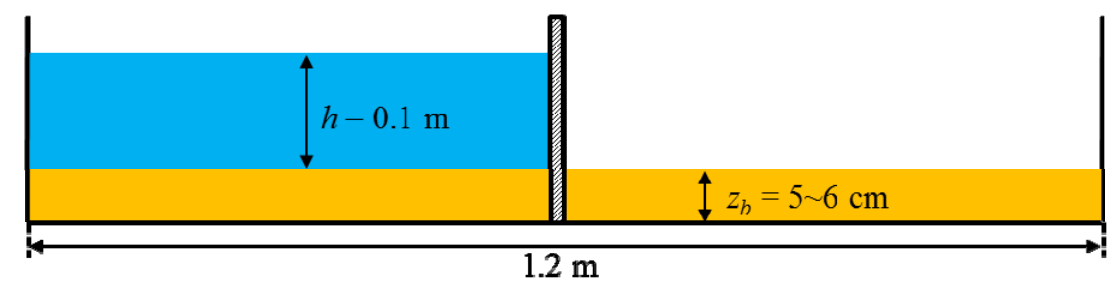
Figure 6. One-dimensional experiment of flood over movable